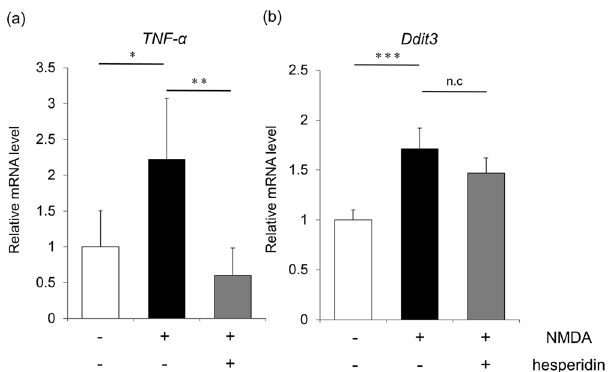
Figure 7. Alterations in the mouse retina in the expression of gene markers for inflammation and ER stress after treatment with NMDA and hesperidin. Damage to the retina after the injection of PBS, NMDA or NMDA/ hesperidin was investigated with quantitative RT-PCR measurement of TNF- α ( a ) and Ddit3 ( b ), which are markers of inflammation and ER stress, respectively (n = 6–7). The expression of each gene was normalized to Gapdh. Data represent mean ± SD. * p < 0.05, ** p <